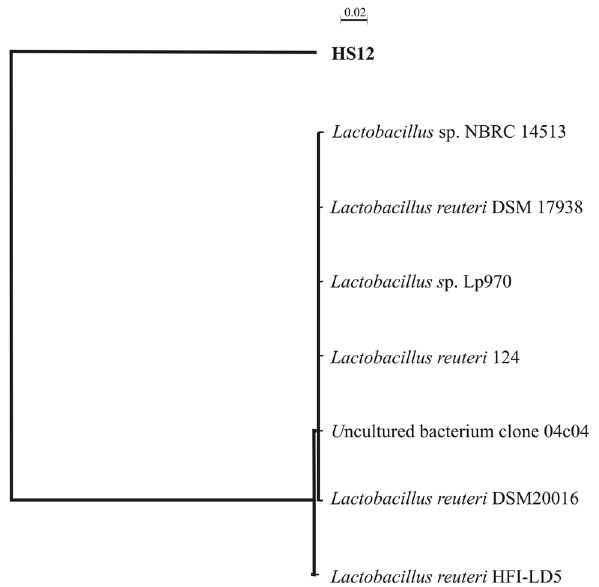
Fig. 6 The phylogenetic tree constructed by neighbor-joining method using 16S rDNA sequence representing the relationship of selected Lactobacillus reuteri HS12 strains with closely related members in GenBank